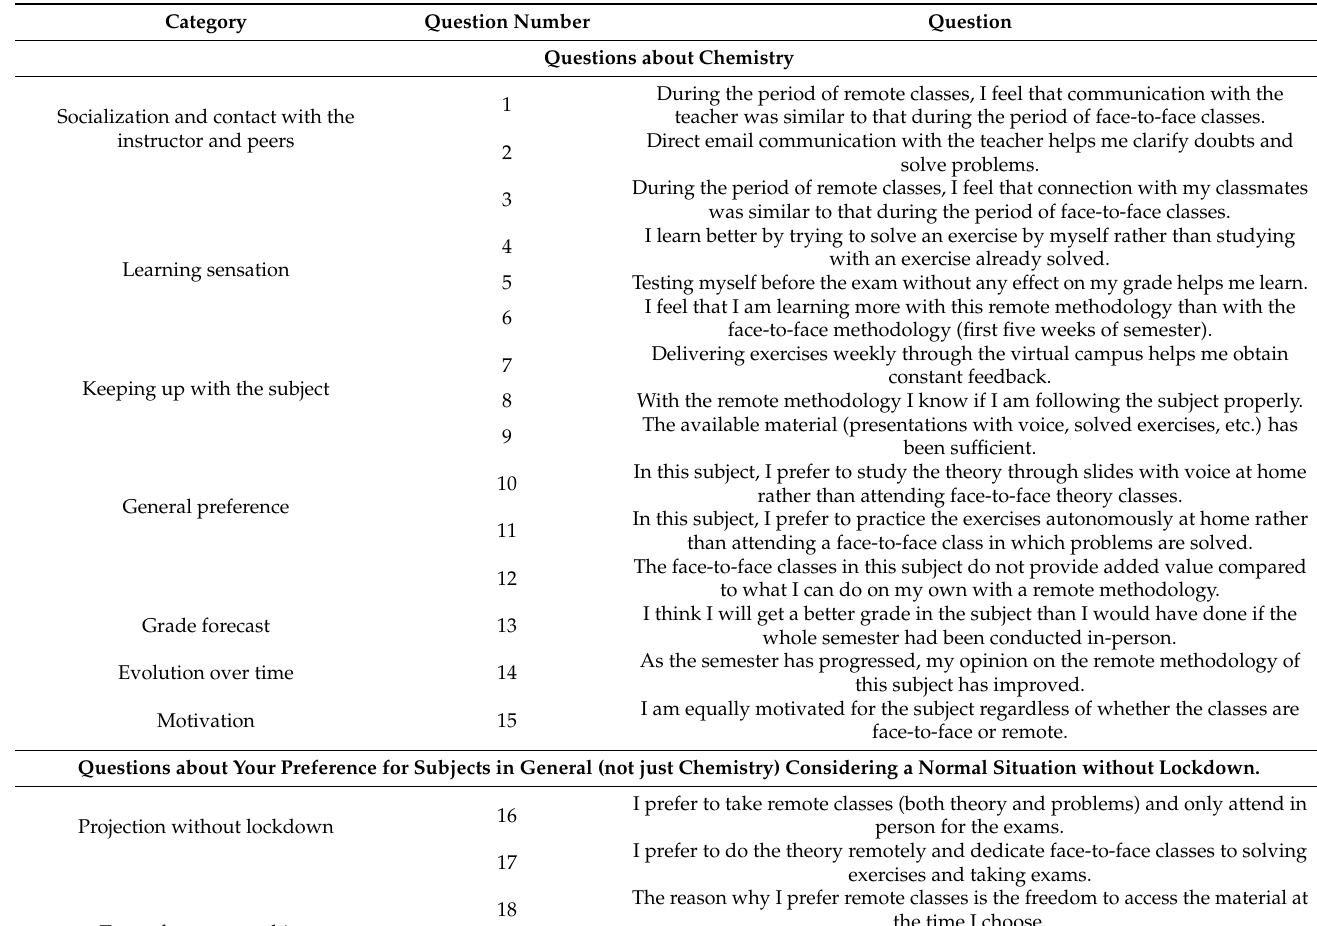
Table 3. English version of the